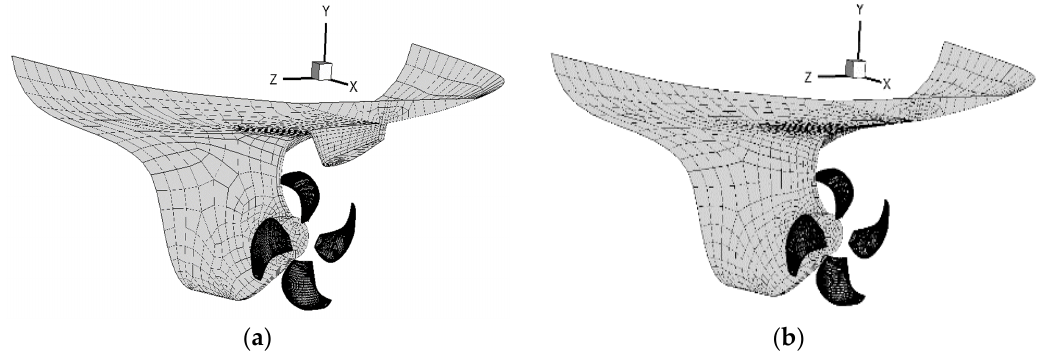
Figure 7. Pressure-BEM model ( a ) with and ( b ) without the upper part of the rudder (the propeller is not a part of this model).